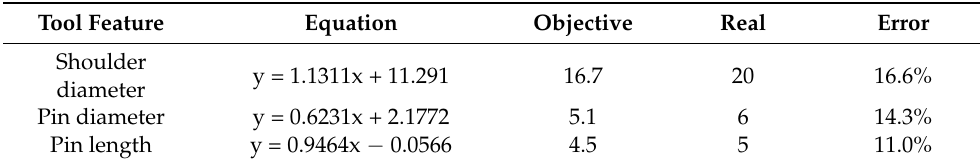
Table 6. Comparison between tool design guidelines and experimental work by other authors for series 5XXX. Table 8. Comparison between tool design guidelines and experimental work by other authors for series 7XXX.